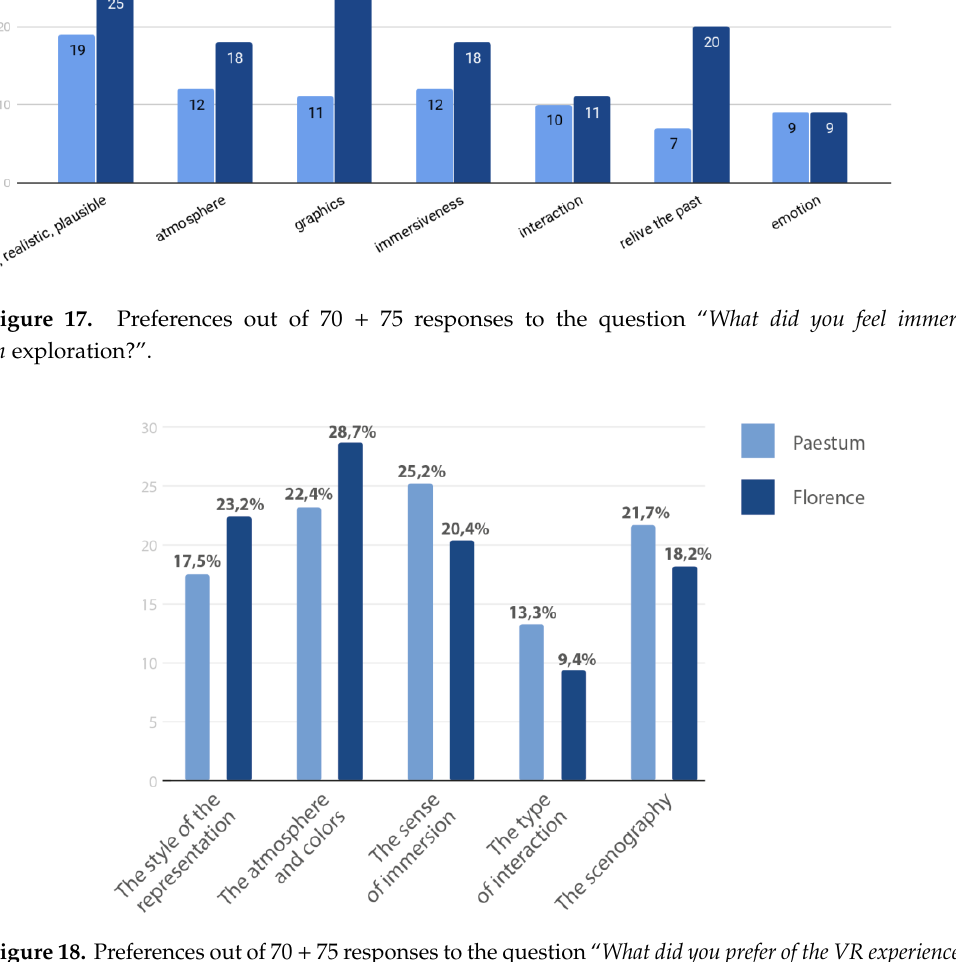
Figure 18. Preferences out of 70 + 75 responses to the question “ What did you prefer of the VR experience ?”.